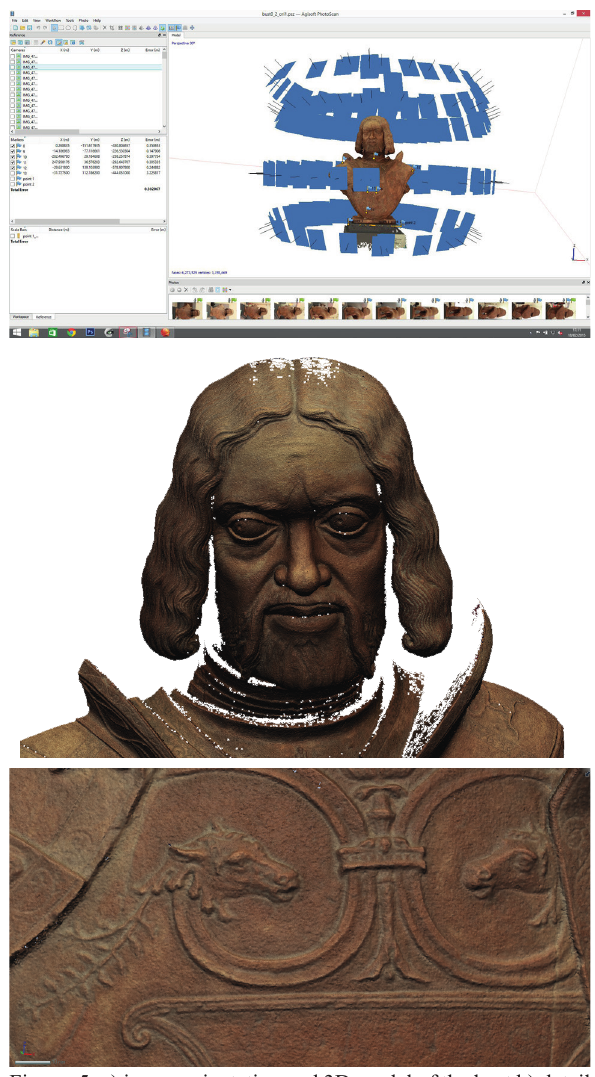
Figure 5: a) image orientation and 3D model of the bust b) detail of head and the